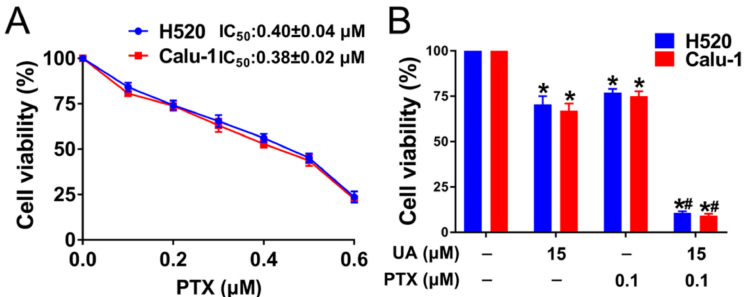
Figure 7. ( + )-Usnic acid (UA) enhances paclitaxel cytotoxicity in LUSC cells. ( A ) Cell viability assessed by MTT after treatment with PTX at the indicated concentrations, n = 3. ( B ) The e ff ect of UA plus PTX on H520 and Calu-1 cell viability determined by MTT assay. H520 and Calu-1 cells were exposed to di ff erent concentration of UA and PTX for 48 h. Significantly di ff erent from control group, * p < 0.05, n = 3; # significantly di ff erent from the group of UA or PTX, p < 0.05, n = 3.